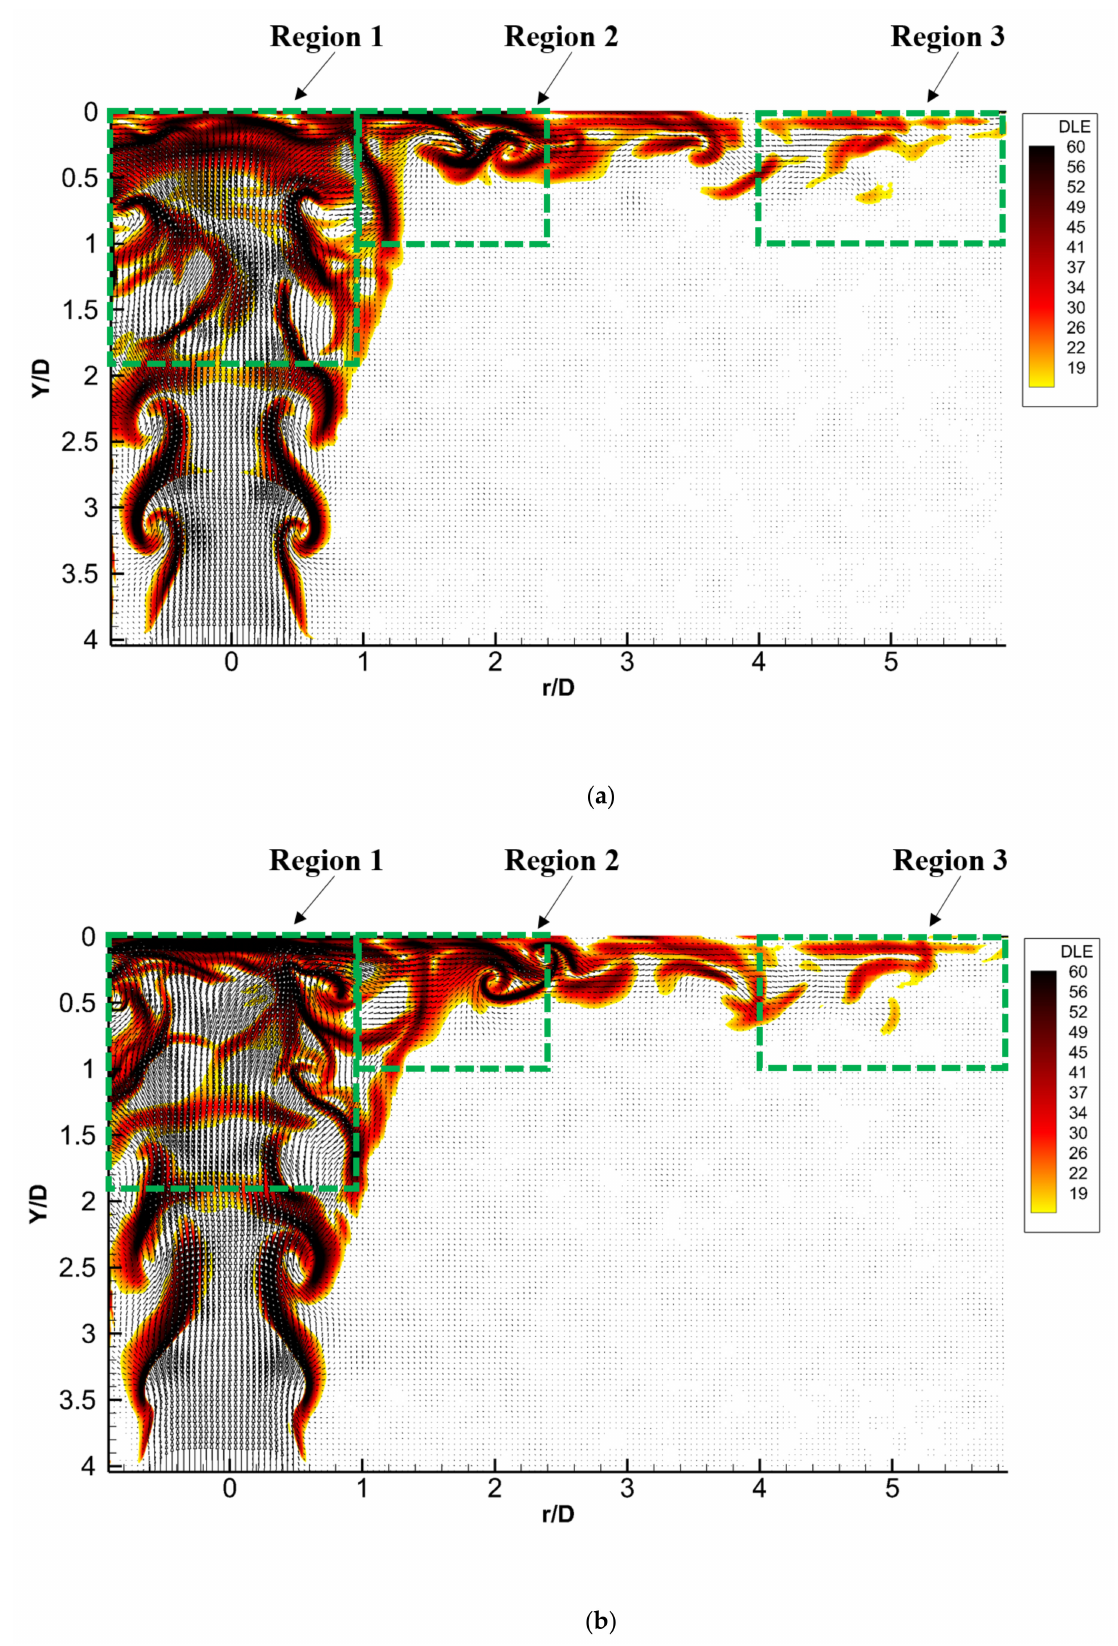
Figure 7. FTLE and velocity fields for the rotational case ( a ) t = t1 and ( b ) t = t1 + 30